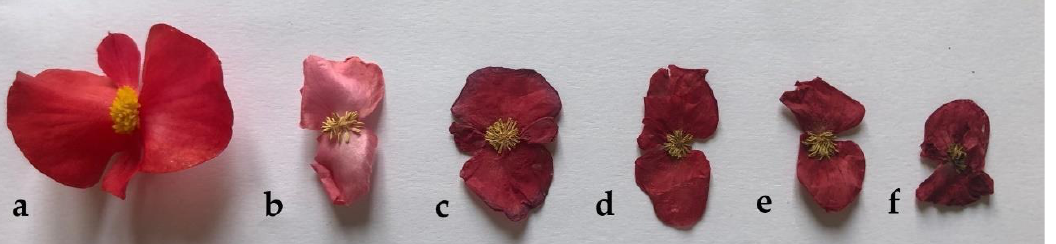
Figure 2. Visual quality of B. cucullata flowers. Fresh ( a ), freeze-dried (FD; b ), hot-air dried (HAD) 50 °C ( c ), HAD 60 °C ( d ), HAD 70 °C ( e ), HAD 80 °C ( f ). Table 1. CIE L*a*b* color parameters of the B. cucullata flowers subjected to different postharvest treatments . Abbreviation: FD — freeze-dried; HAD — hot-air dried.